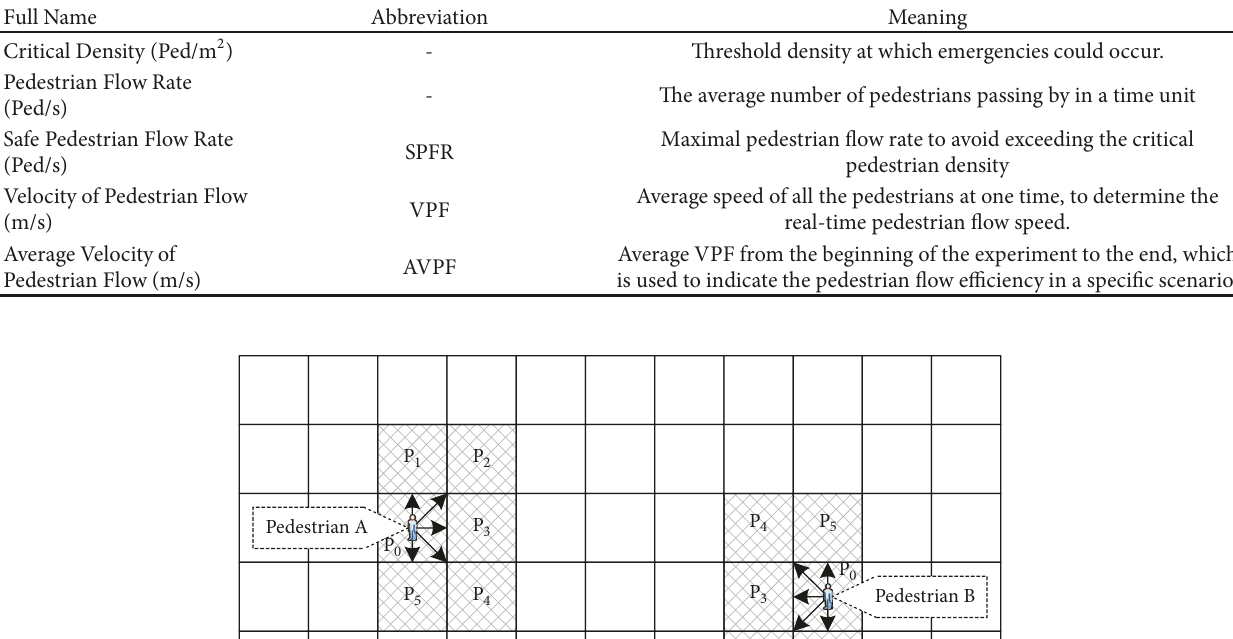
Table 2: Main pedestrian flow measures.